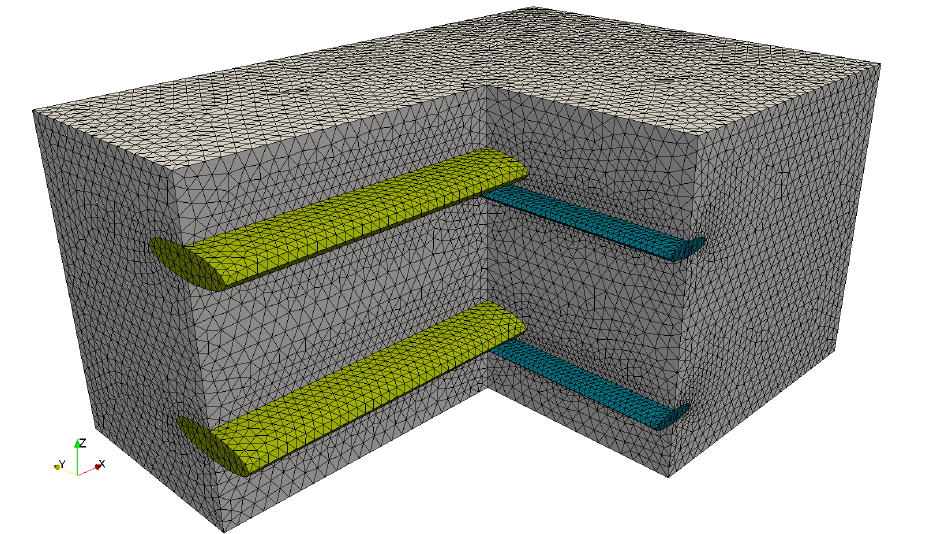
Figure 4. Finite element mesh of two layered TRC-RVE with 4 × 143,492 linear tetrahedral elements, 4 × 3700 cohesive zone elements and 4 × 28,126